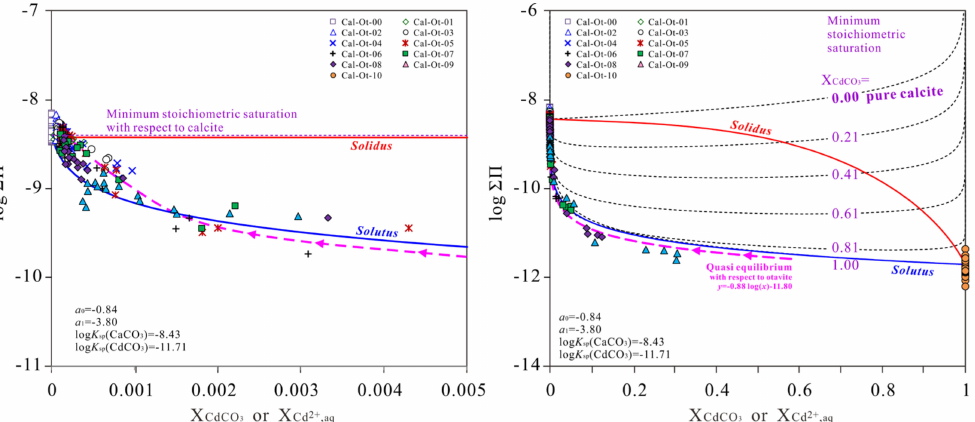
Figure 7. Lippmann diagram for the non-ideal (Ca 1 − x Cd x )CO 3 solid solutions together with the plot of some stoichiometric saturation curves and the experimental data for dissolution in the N 2 -degassed water. The graph on the left is a zoom of the one on the right.